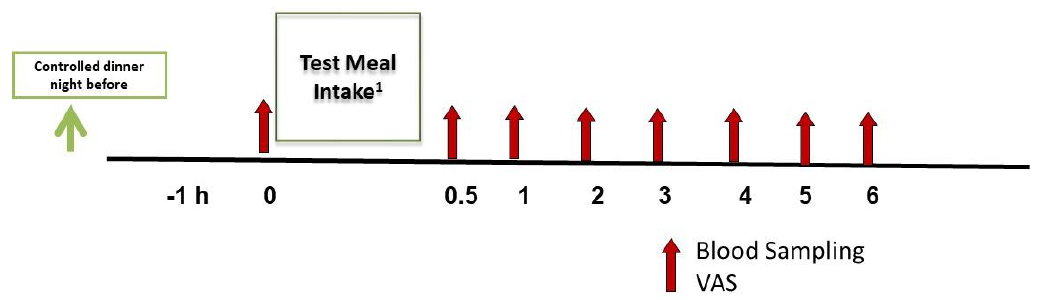
Figure 2. Six hour postprandial study day schema. VAS, visual analog scales. 1 One of three test